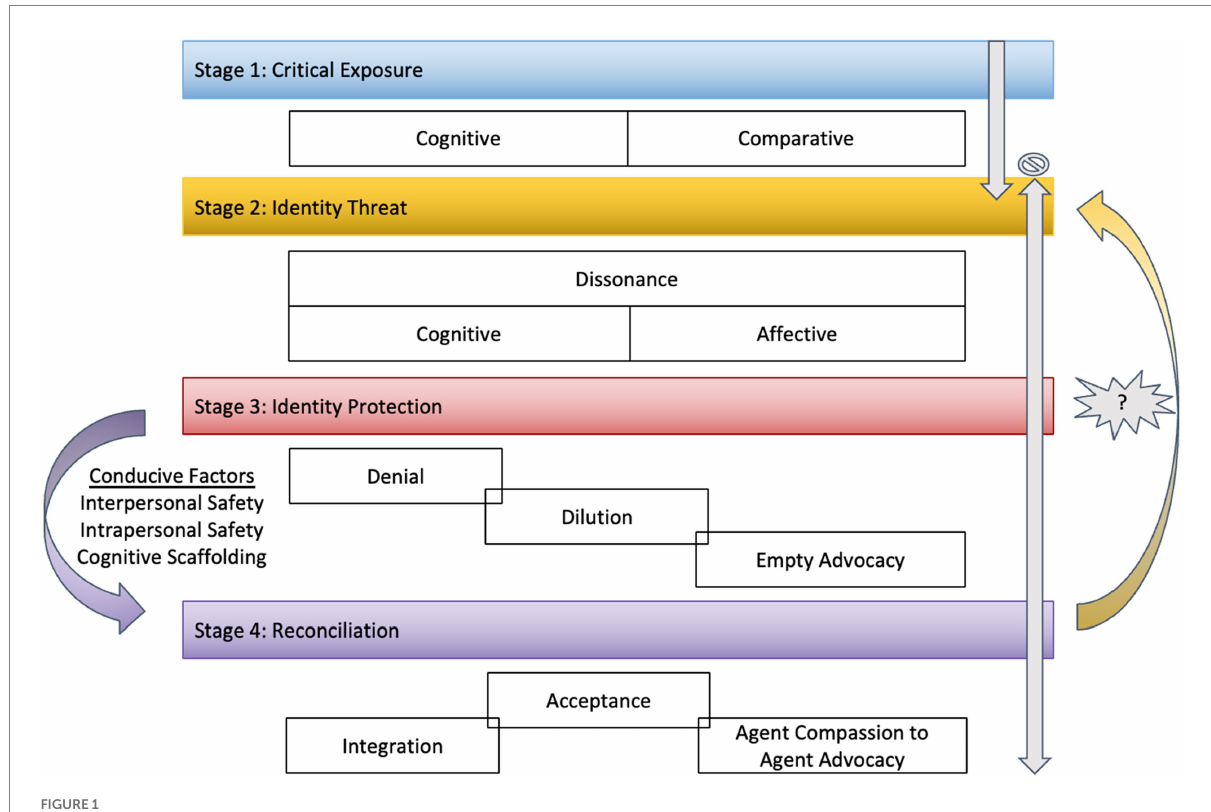
FIGURE 1 Model of Integrating Awareness of a Privileged Social Identity